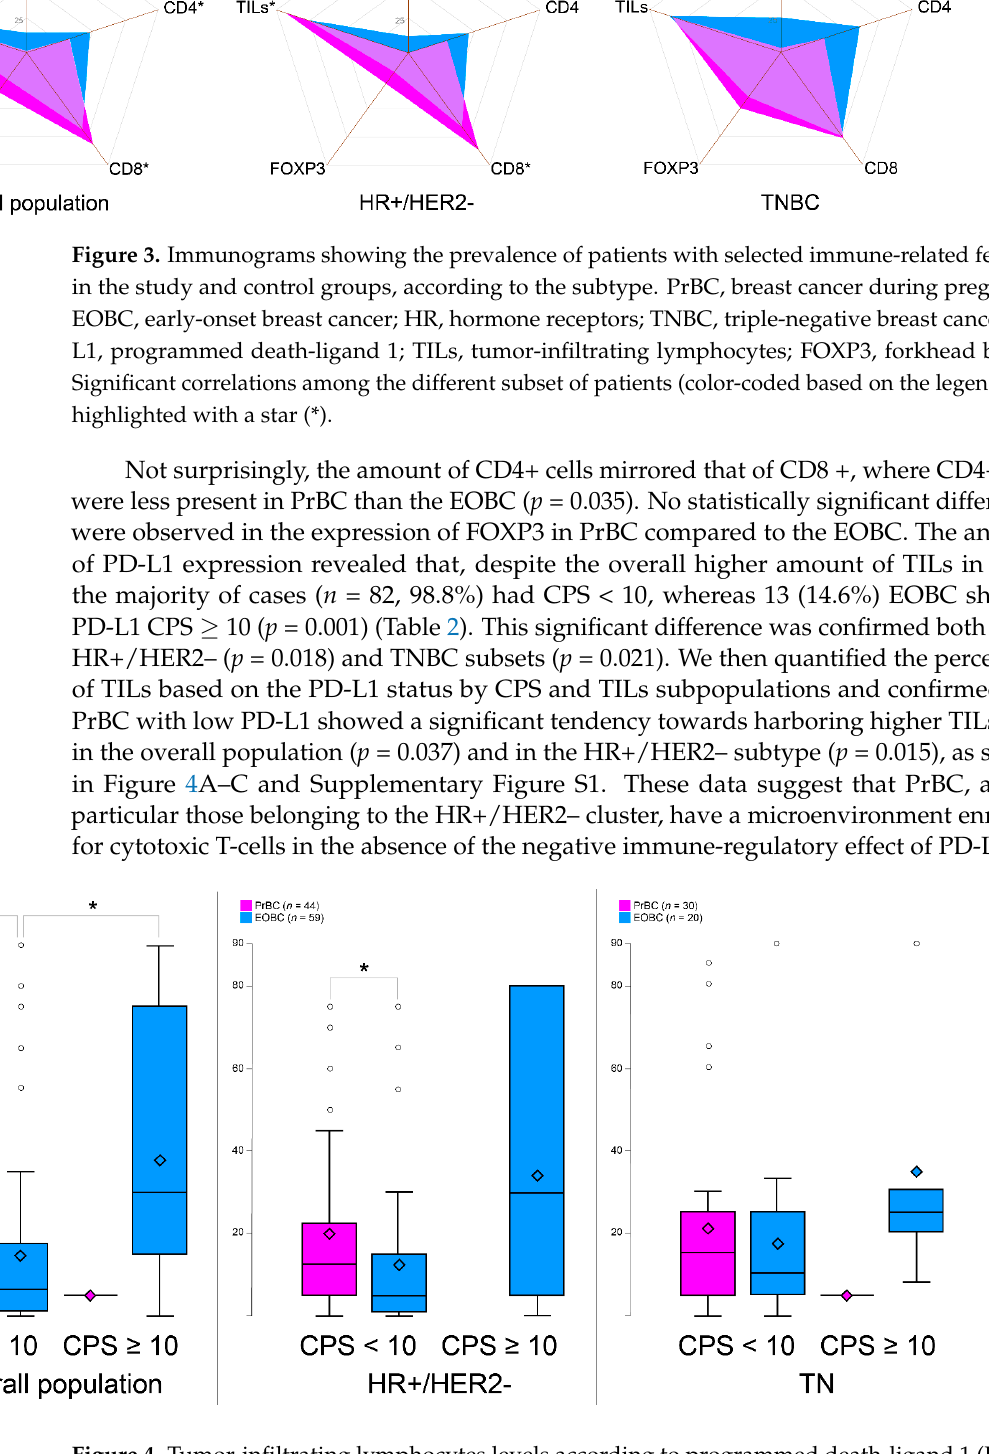
Figure 4. Tumor-infiltrating lymphocytes levels according to programmed death-ligand 1 (PD-L1)